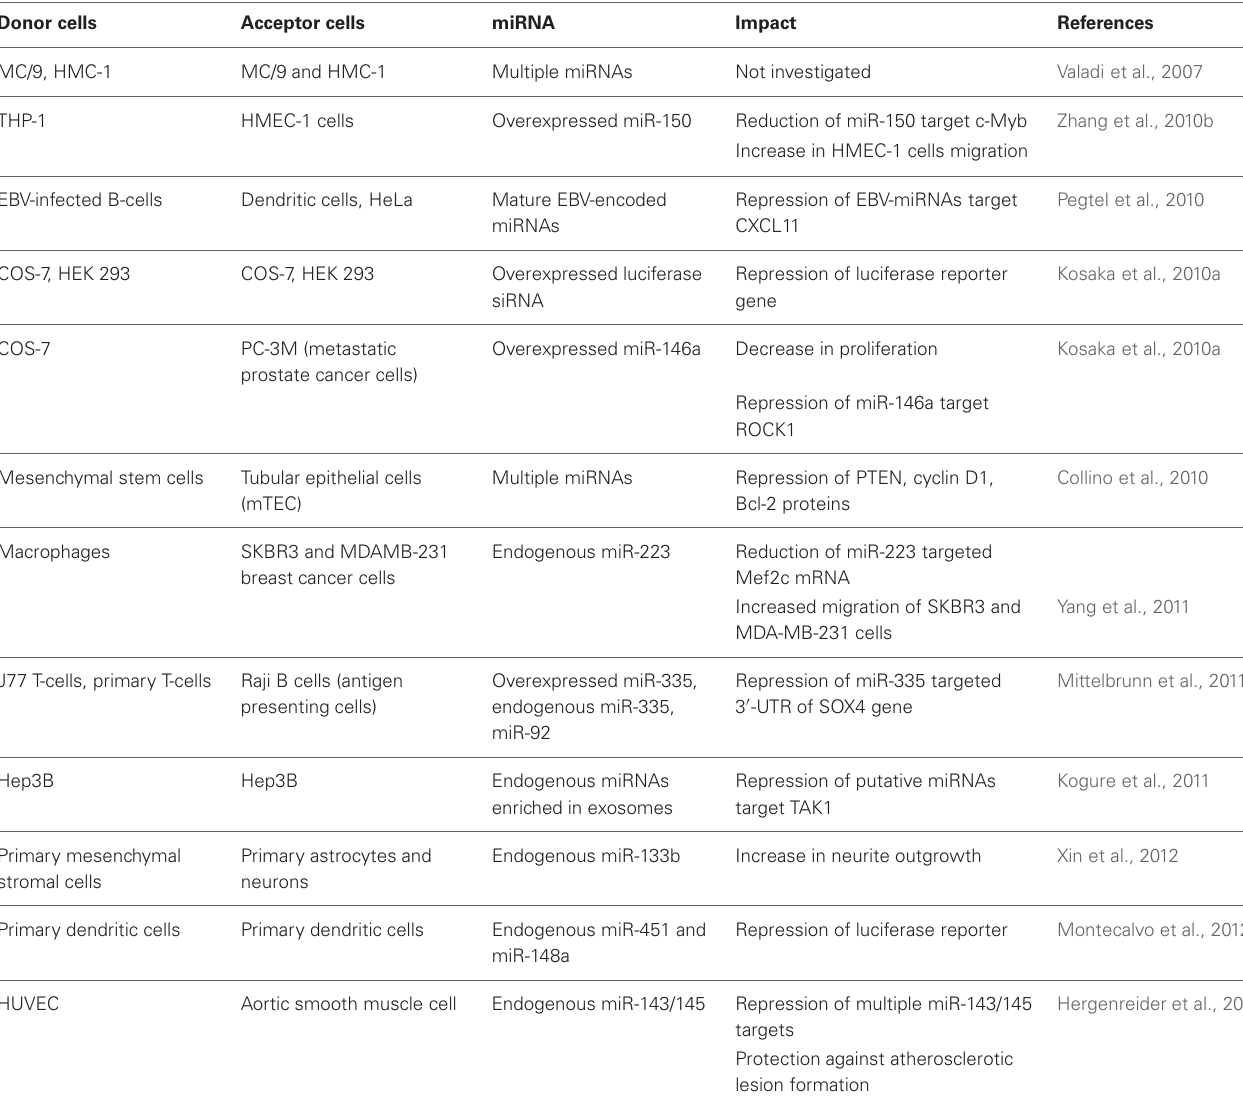
Table 1 | Reports demonstrating cell–cell transfer of extracellular